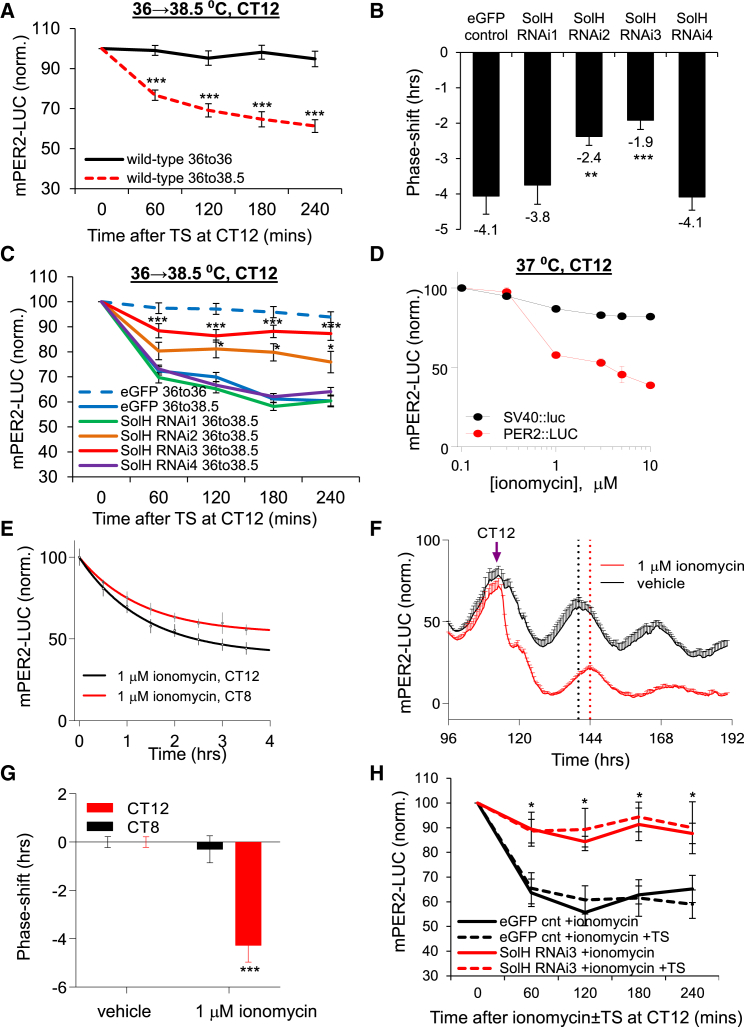
Temperature Shifts the Mammalian Clock through SOLH-Mediated Degradation of mPER2(A) A 4-hr temperature shift triggers mPER2 degradation at CT12 (defined by peak PER2::LUC bioluminescence) in mammalian immortalized liver cells.(B and C) SOLH downregulation using shRNA reduces thermal phase shifts (B) and mPER2 degradation in immortalized liver cells at CT12 (C).(D) Intracellular Ca2+ induced by ionomycin degrades mPER2 in a dose-dependent manner at CT12 in lung fibroblasts.(E–G) Ionomycin results in mPER2 degradation both at CT8 and CT12 (E), and phase delays molecular rhythms at CT12 in lung cells (F and G).(H) Ionomycin-induced mPER2 degradation in liver cells is SOLH dependent and not additive with TP, suggesting that Ca2+ and temperature are on the same pathway. Error bars represent SD for (B) and SEM for others. p < 0.05, p < 0.01, or p < 0.001 from at least three independent experiments (n ≥ 6 each) is indicated with “∗,” “∗∗,” or “∗∗∗,” respectively.See also Figure S6.